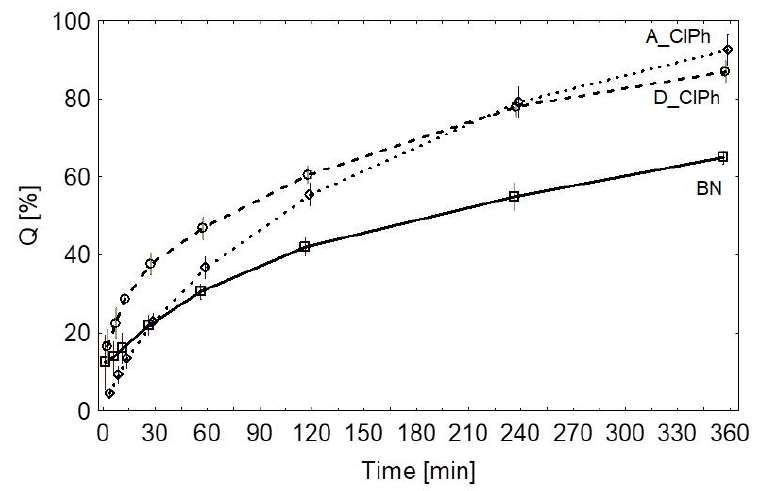
Figure 6. Q diagram for the values of the released percentage over time. Mean; Whisker: Mean ± 0.95 Conf. Interval. ○ mean release points of D_ClPh; □ mean release points of BN; ◊ mean release points of A_ClPh.